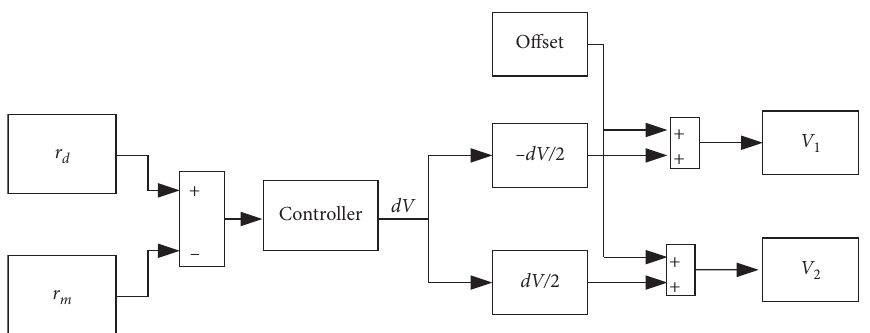
Figure 5: The PID control of the differential steering.